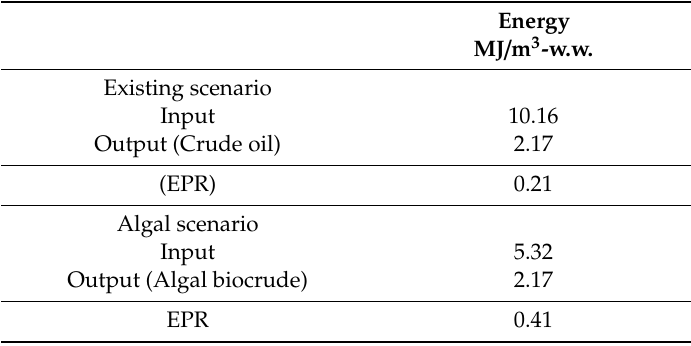
Table 9. Operating energy balance of each scenario.